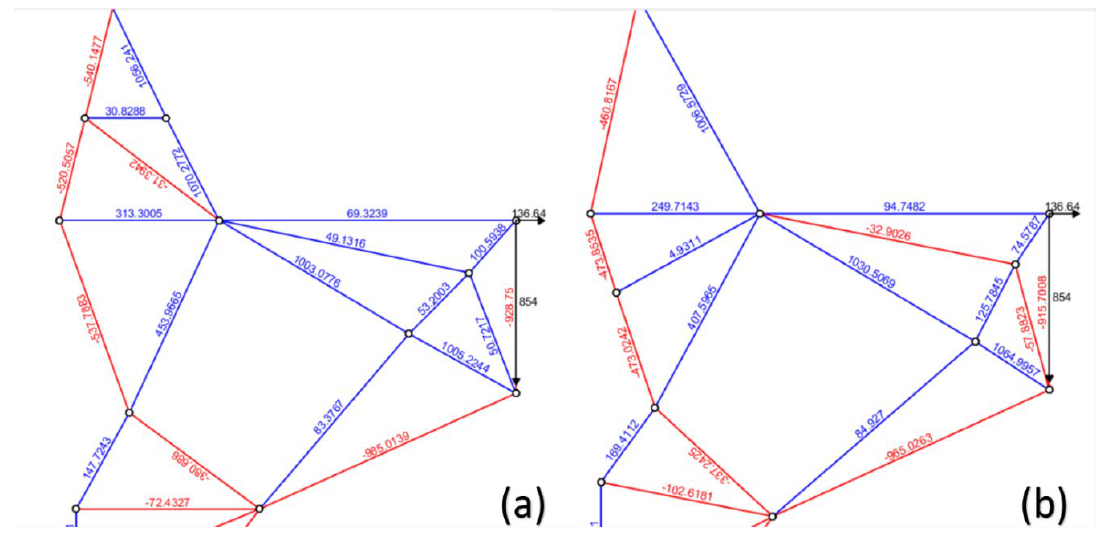
Figure 19. Load details in the trapezoidal corbel a) f = 50%; b) f = 40%